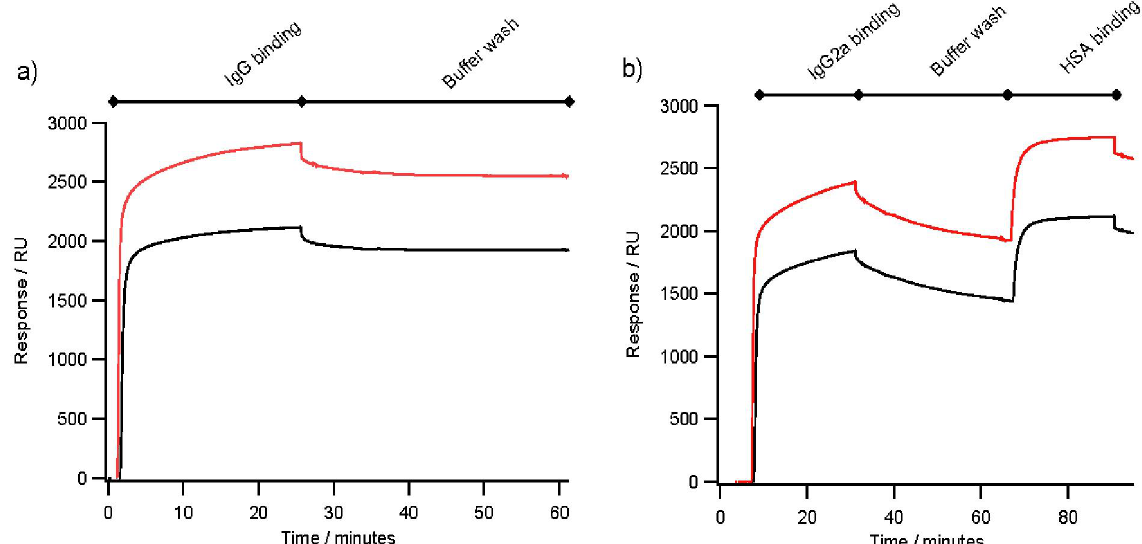
Figure 4. Comparing antibody binding between arrays of ZZctOmpA (black traces) and ZZlinkZZctOmpA (red traces). The arrays were assembled as in Figure 2 and IgG at 30 μg mL −1 in PBS was flowed over the arrays at 2 μL min −1 . After the antibody injection PBS running buffer was flowed over the array to measure the dissociation of antibody from the array. 0.1 mg mL −1 HSA was injected at 2 μL min −1 . ( a ) The binding of